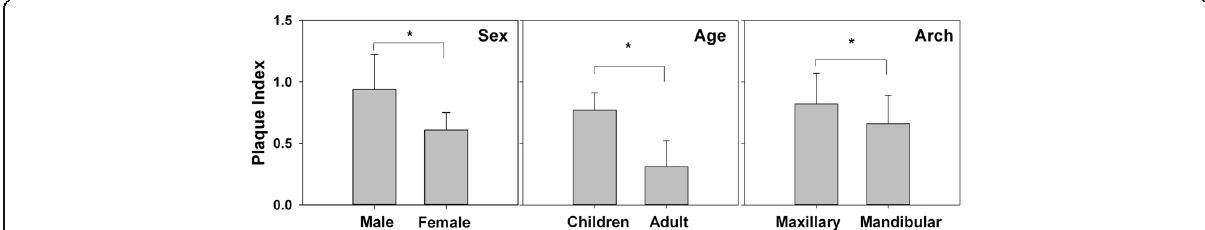
Fig. 3 Comparison of biofilm formation by sex, age group, and arch. Males had significantly more biofilm than females ( P < 0.001). Children had